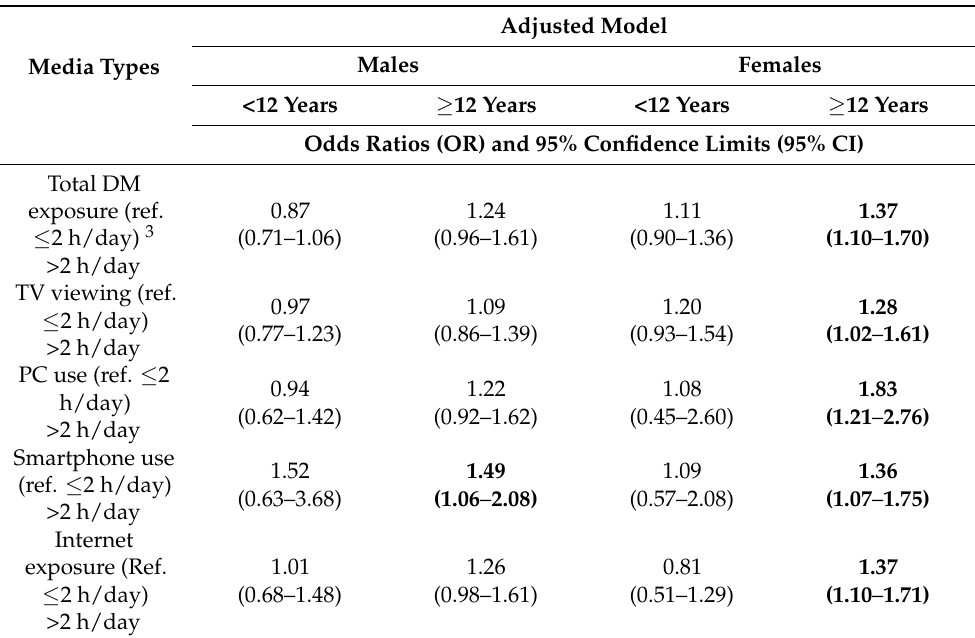
Table 4. Exposure to digital media in association with fatty taste preference in European children and adolescents 1,2